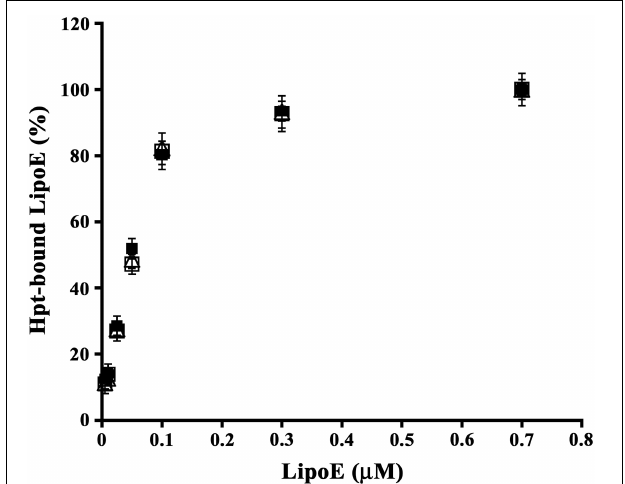
FIGURE 1 | Binding of Hpt to ApoE isoforms. Aliquots of 0.2 μ M Hpt were loaded into the wells of a microtitre plate, and then incubated with different concentrations (0.005–0.7 μ M) of LipoE2 (open triangles), or LipoE3 (open squares) or LipoE4 (solid squares). The amount of apolipoprotein bound to Hpt was detected by goat anti-ApoE and RAG-HRP, measured as absorbance at 492nm, and reported as percentage of the value obtained with 0.7 μ M protein (assumed as 100% of ApoE binding to Hpt). Samples were processed in triplicate. Data were expressed as mean ± s.e.m. vs. μ molar